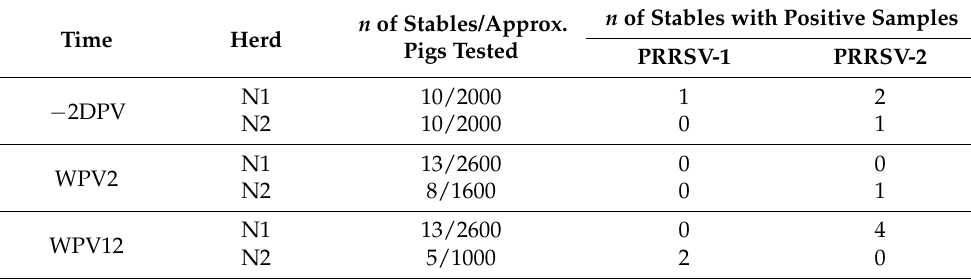
Table 1. RT-qPCR. PRRS virus-positive samples in stables in the two nursery herds (N1 and N2) tested by RT-qPCR. In total, 236 pooled OF samples from nursery pigs before sow mass vaccination ( − 2DPV), two weeks after vaccination (WPV2) or 12 weeks after vaccination (WPV12) were tested. n of Stables/Approx. Time Herd Pigs Tested PRRSV-1